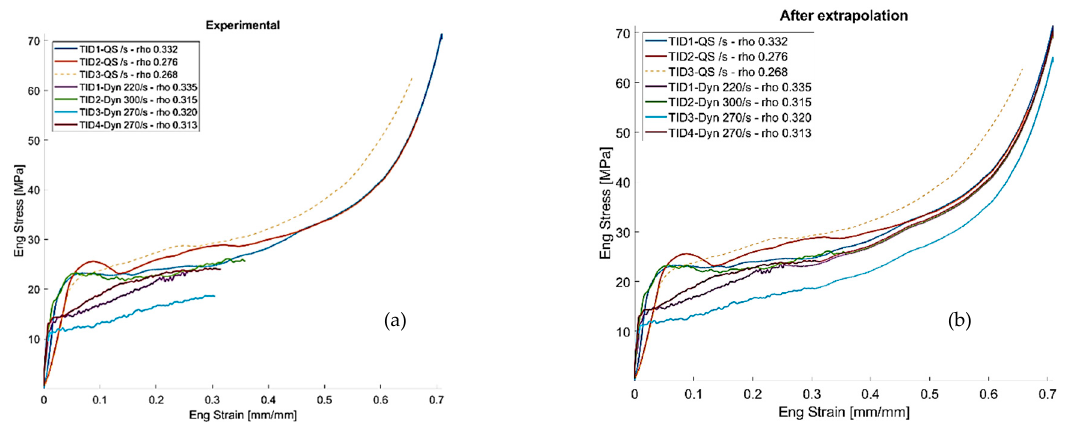
Figure 9. Stress–strain curves obtained in quasi-static conditions and at different strain rates ( a ) before and ( b ) after ex- trapolation.